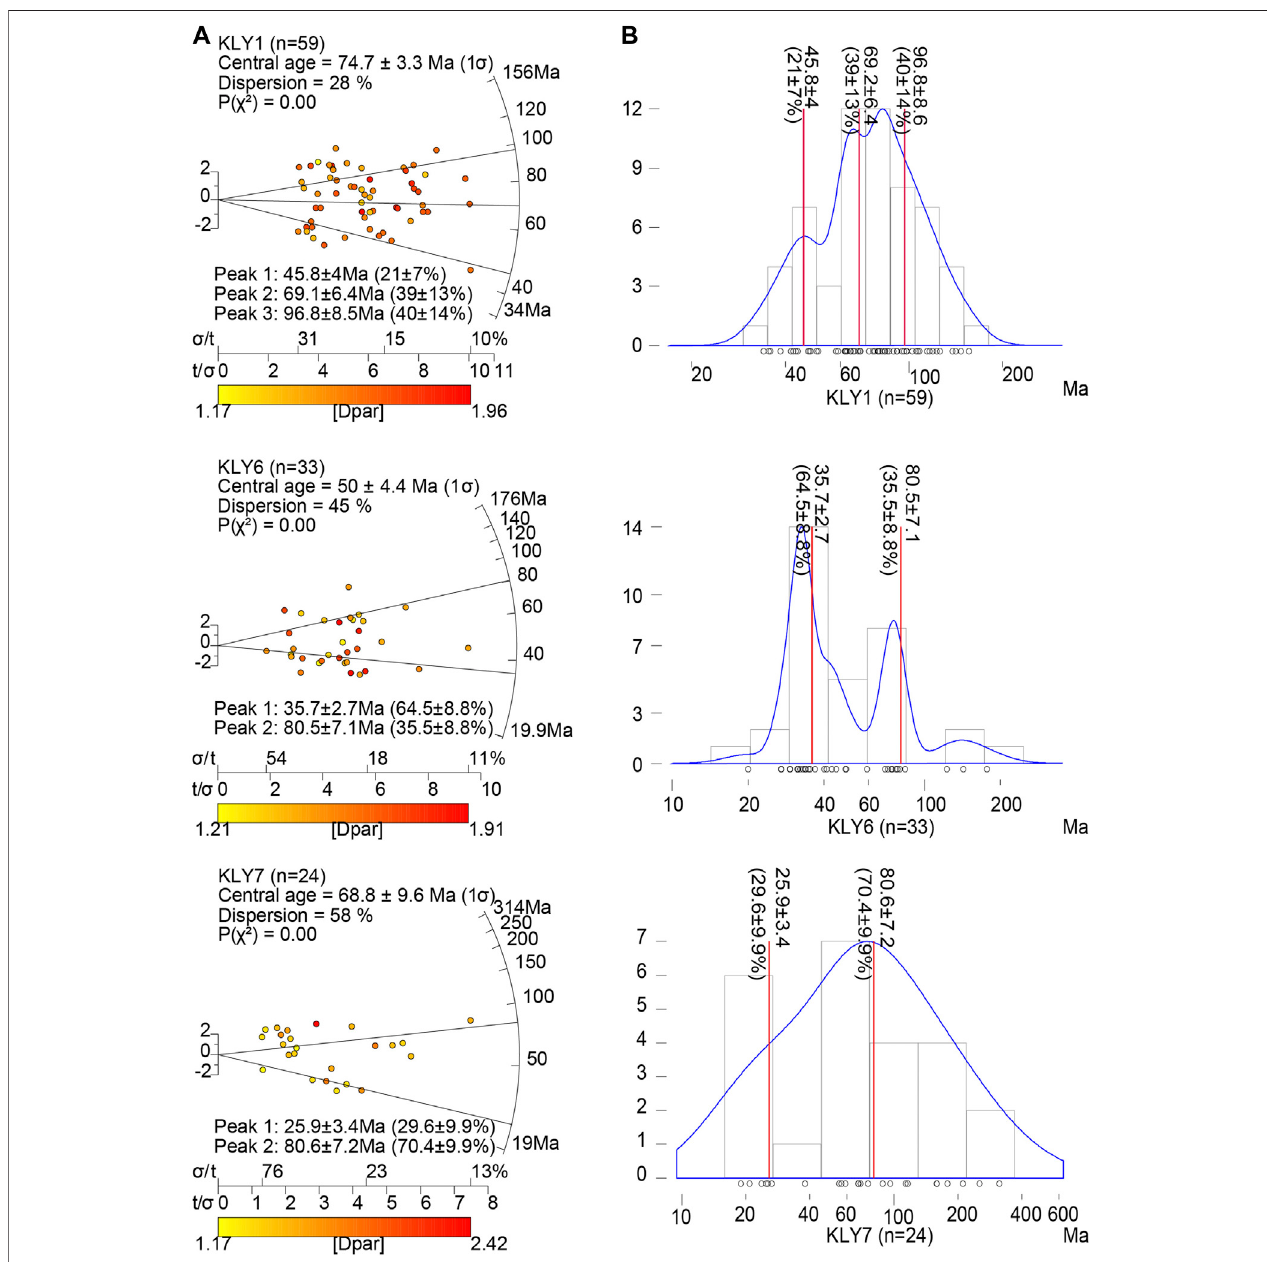
FIGURE5| Apatite fi ssion-trackradialplots (A) andpeakageplots (B) oftheKeliyangsection.Inthepeakageplots,theblueandredlinesrepresentthe fi ttedcurve and peak values, respectively.